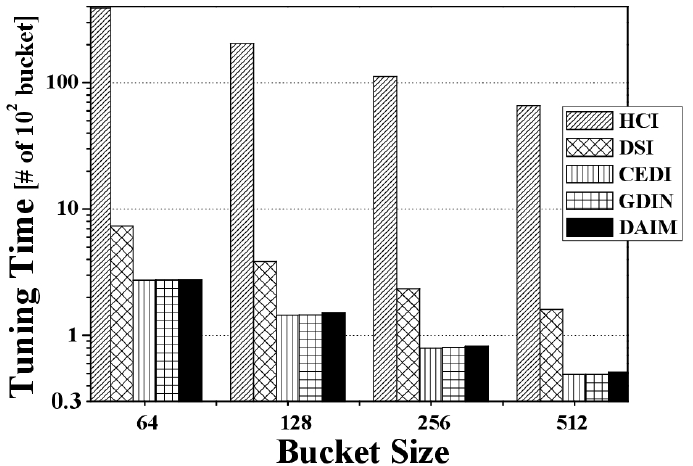
Figure 13. The comparison of the tuning time over various bucket sizes.